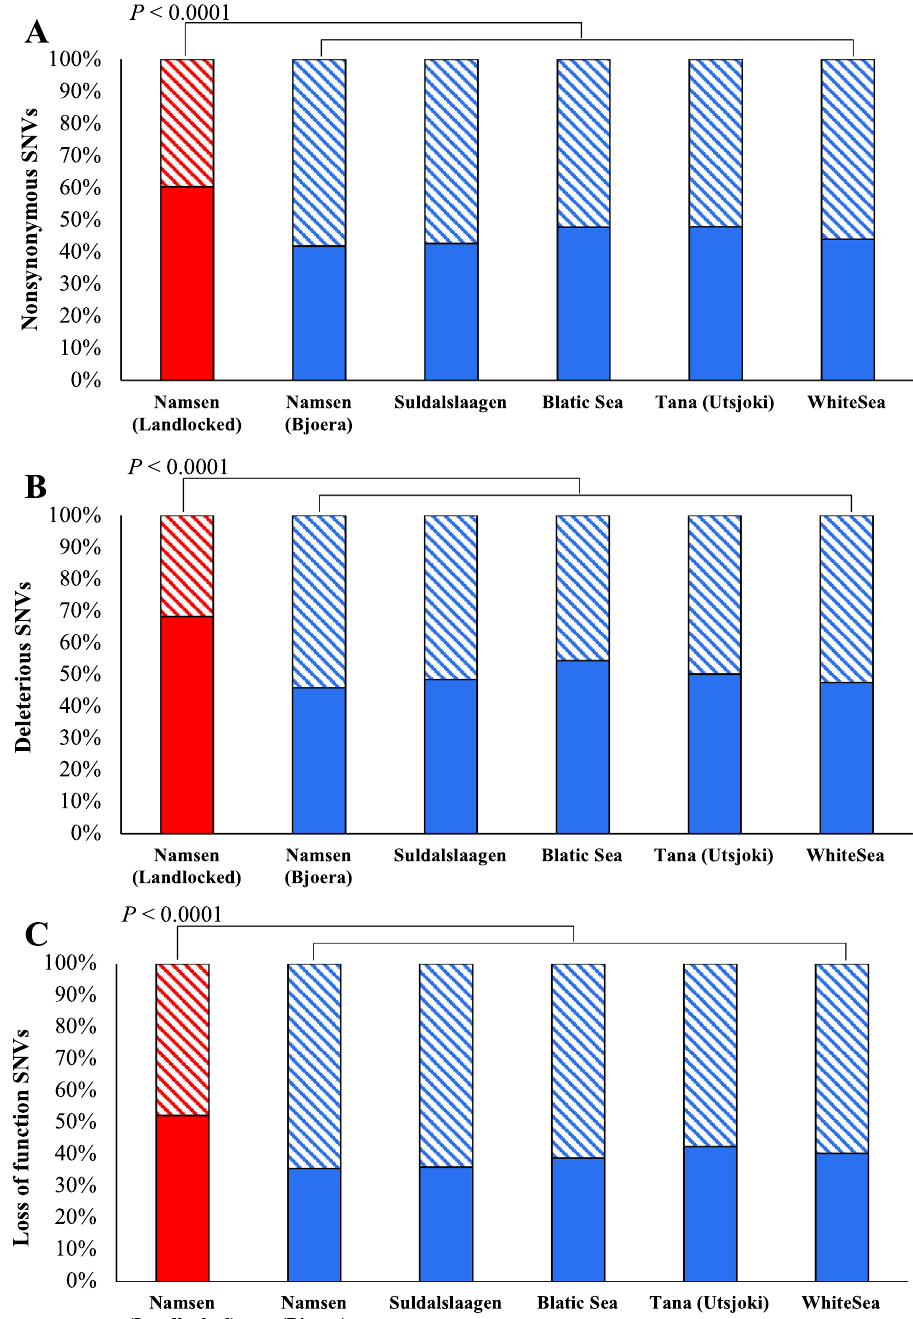
Figure 5. The stacked bar shows the proportions of homozygous (solid) and heterozygous (stripped) SNVs estimated for landlocked and anadromous salmon populations. ( A ) Nonsynonymous SNVs ( B ) Deleterious SNVs ( C ) Loss of function (LoF) SNVs. The number of homozygous SNVs in landlocked salmons was significantly higher than those estimated for the anadromous salmon, and this is true for the comparisons involving nonsynonymous, deleterious, and LoF SNVs (at least P <